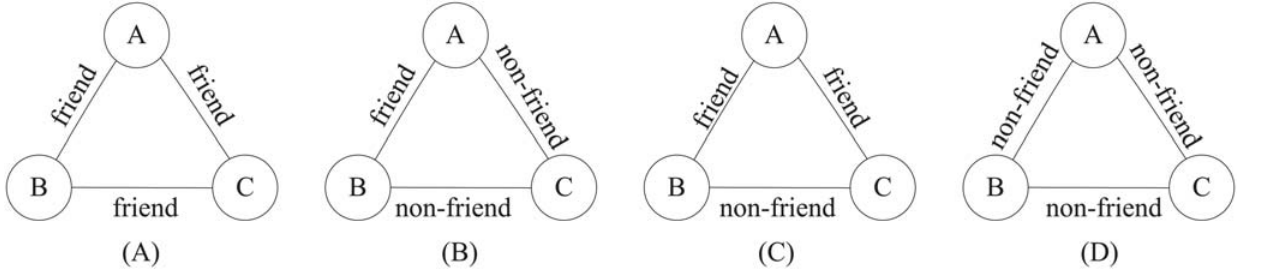
Fig 3. Illustration of structural balance theory. Triads (A) and (B) are balanced, while (C) and (D) are not balanced.